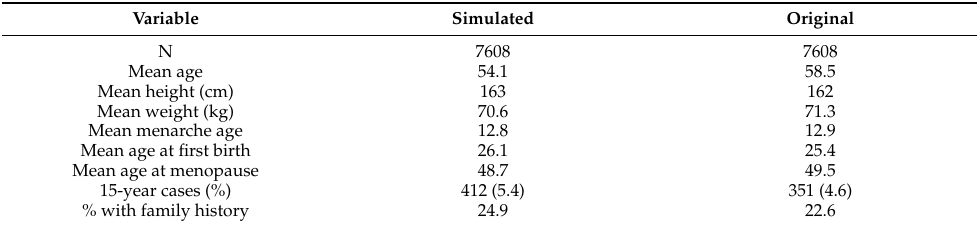
Table A7. Characteristics of simulated and original datasets. Family history is defined as family history of breast cancer in first- or second-degree relatives.